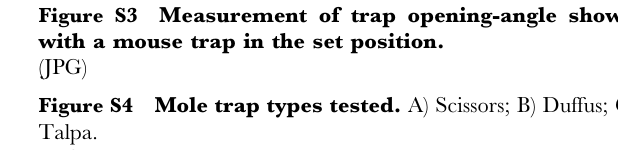
Figure S3 Measurement of trap opening-angle shown with a mouse trap in the set position. (JPG) Figure S4 Mole trap types tested. A) Scissors; B) Duffus; C) Talpa. (JPG) Figure S5 Dynamic load cell in aluminium jig (with scissors trap). Figure S6 Raw data for impact momentum against clamping force in mouse and rat traps. A) mouse traps; B) rat traps. Each point represents a separate measurement and measurements from the same trap are enclosed within a polygon. Points marked Ma-f (labelled blue) and Ra-f (labelled red) are trap types in the mouse and rat replicated sets respectively, and are identified on Figures 1 and 2. Table S1 Rat and mouse break-back trap types tested in the study. A) rat traps; B) mouse traps. Numbers relate to labels shown in Figure S1. Traps are presented in alphabetical order. Table S2 The number of rat and mouse trap types and individual traps of each type studied. Table S3 Sample sizes of rat and mouse trap types in each angle category/spring type combination.